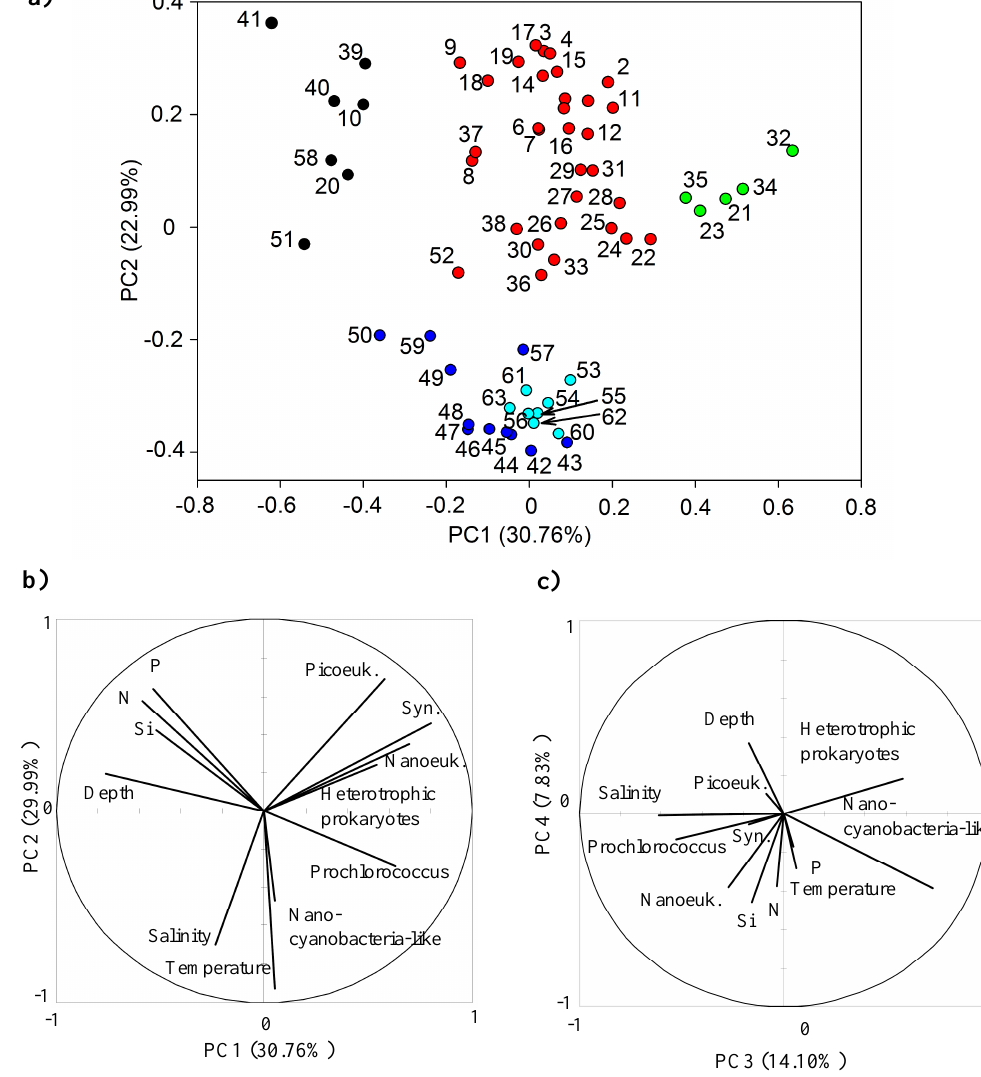
Fig. 14. Hierarchical clustering illustrated for the two first principal components of the principal component analysis performed with the data collected from stations 5 to 11 (a) . According to the classification (Table 1), the sampling depths (illustrated by numbers) were separated into 5 clusters: one characterises the deep layer (Cluster 1, black), another the samples from stations 5 to 8 (Cluster 2, red), a third one the samples with a maximum of abundances (Cluster 3, green), and the two last clusters (4, blue and 5, dark blue) which characterised the southernmost stations. Cluster 5 (dark blue) focuses on station 9 where the salinity front was observed. The circle (b) displays the two first dimensions of the PCA and the circle (c) the dimensions 3 and